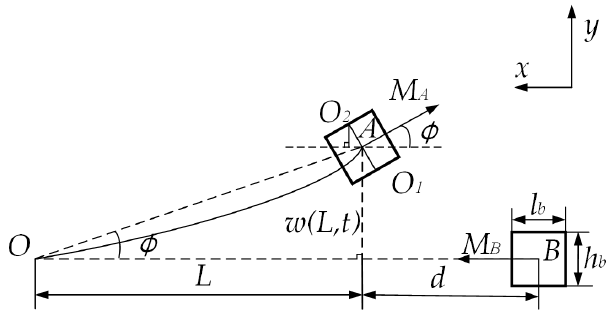
Figure 2. Magnetic force model.